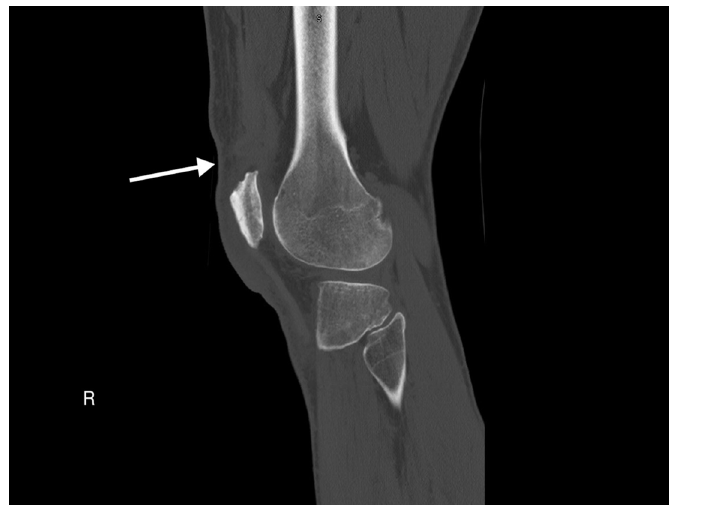
Image 2. Computed tomography of right knee demonstrating near-complete tear of quadriceps tendon with retraction of the central portion of the tendon (arrow).